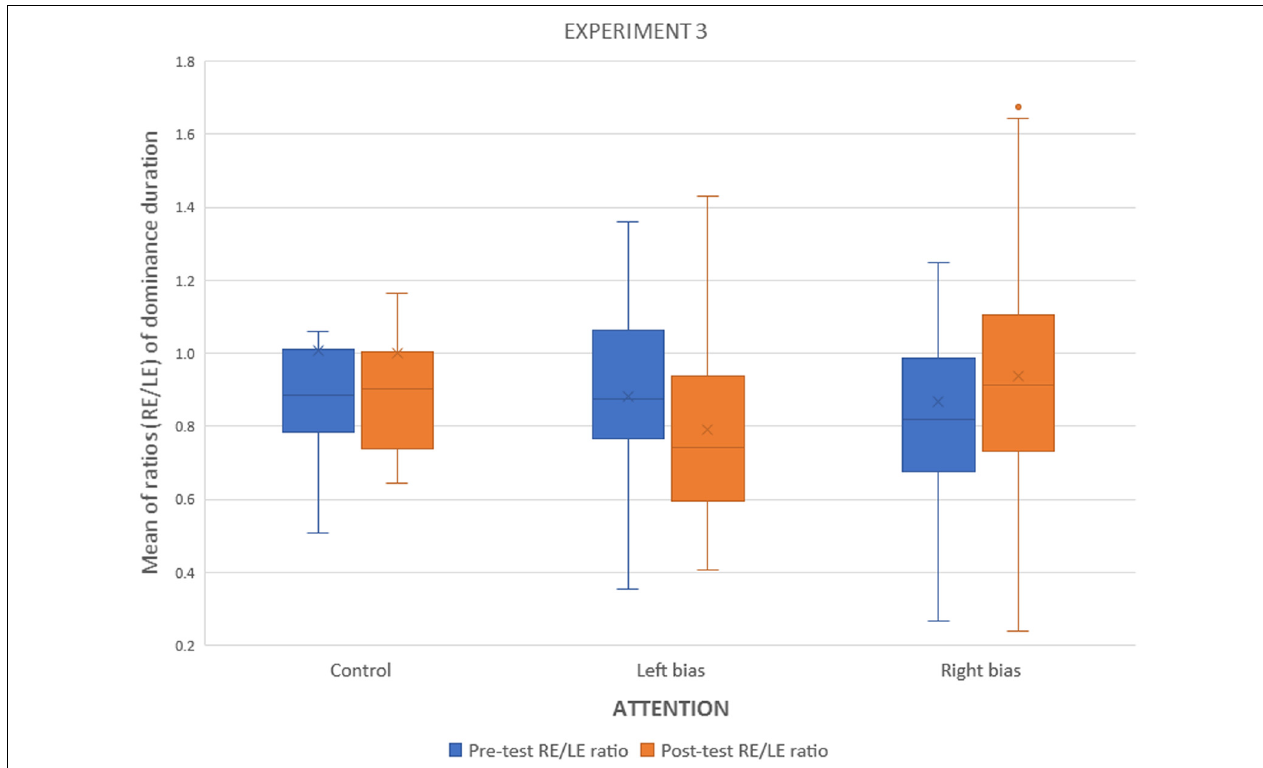
FIGURE 8 | Experiment 3. Interocular ratios (right/left) of dominance durations before and after the monocular counting task.